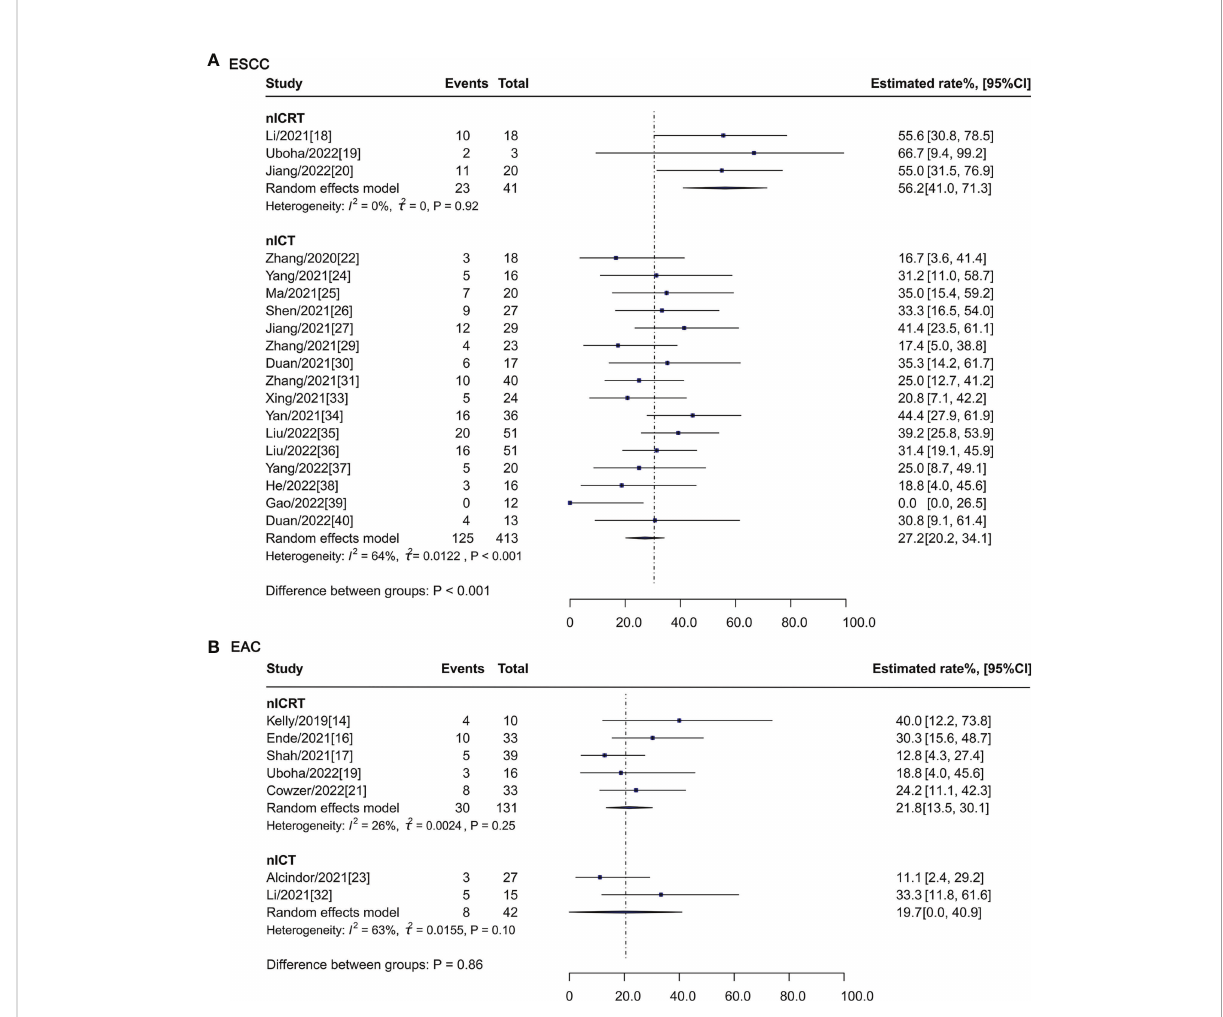
FIGURE 4 Subgroup analysis of pCR rate according to histological type. pCR, pathological complete response; nICRT, neoadjuvant immune checkpoint inhibitor in combination with chemoradiotherapy; nICT, neoadjuvant immune checkpoint inhibitor in combination with chemotherapy; ESCC, esophageal squamous cell carcinoma; EAC, esophageal